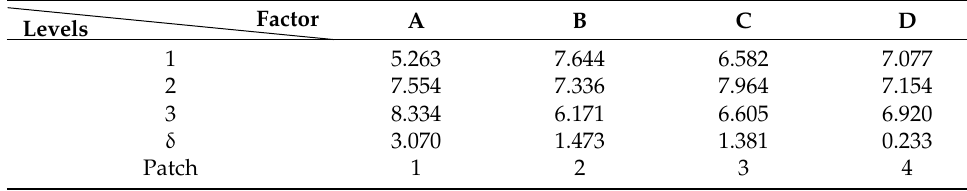
The mean value of the scratch damage depth was subsequently analyzed, with the Table 4. Scratch depth mean value analysis. results shown in Table 4. After comparing the calculation results for the same factor at